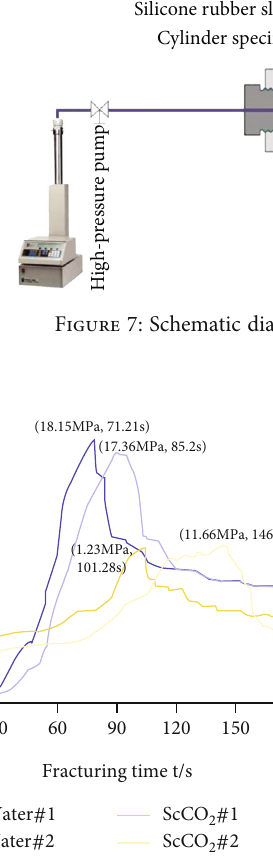
Figure 8: Fracturing pressure versus time curves of the coals for hydraulic and ScCO 2